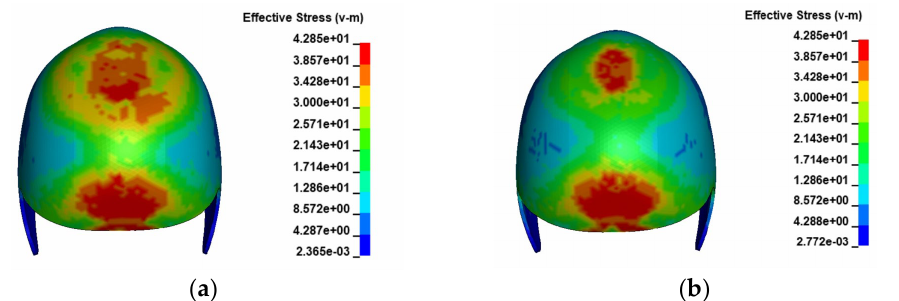
Figure 14. Stress distribution upon impact with a footpath at 27 kph. ( a ) Impact angle: 45 degrees; ( b ) impact angle: 60 degrees.